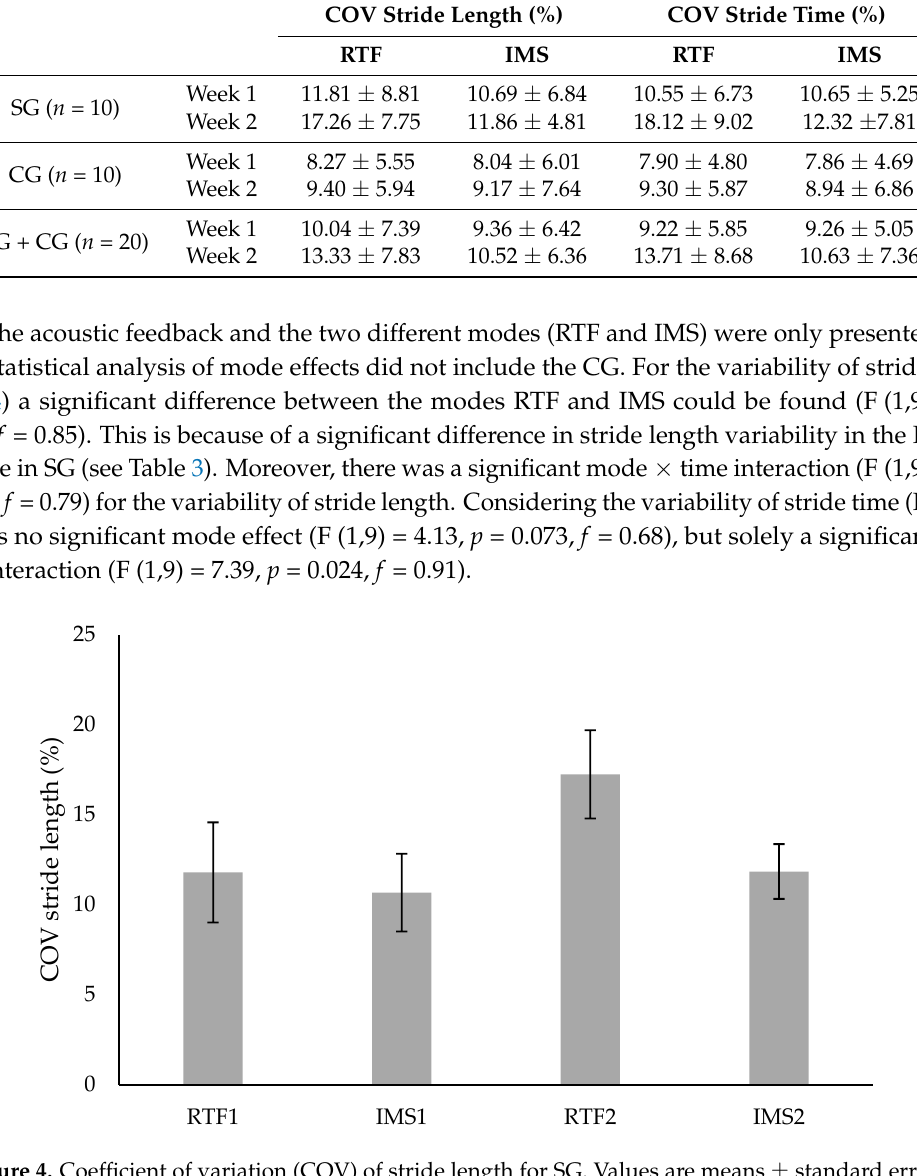
Figure 5. Coefficient of variation (COV) of stride time for SG. Values are means ± standard error. 3.3. Temporo-Spatial Parameters The results showed overall significant improvements from week 1 to week 2 in gait speed (F (1,18) = 15.63, p = 0.001, f = 0.93), cadence (F (1,18) = 20.68, p < 0.005, f = 1.07), stride time (F (1,18) = 12.9, p = 0.002, f = 0.85), and stride length (F (1,18) = 6.56, p = 0.020, f = 0.60) (Table 4). No significant differences between groups were found regarding gait speed, cadence, stride length, and stride time.